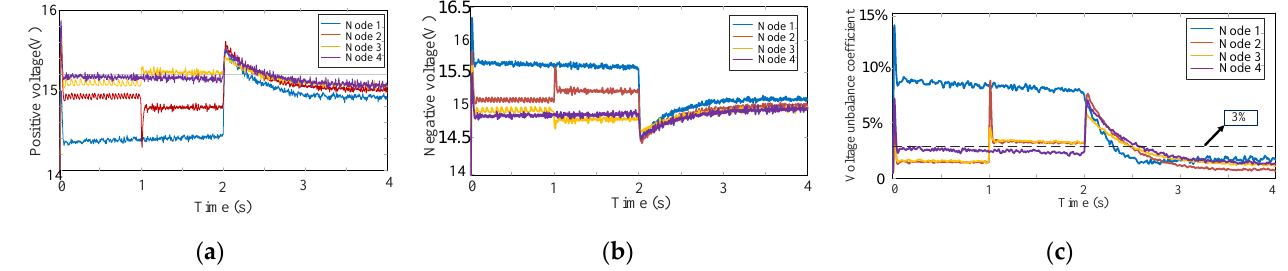
Figure 15. Under the condition of high line resistance, the influence of traditional droop control and consensus control on the ( a ) positive voltage, ( b ) negative voltage and ( c ) voltage unbalance coefficient.